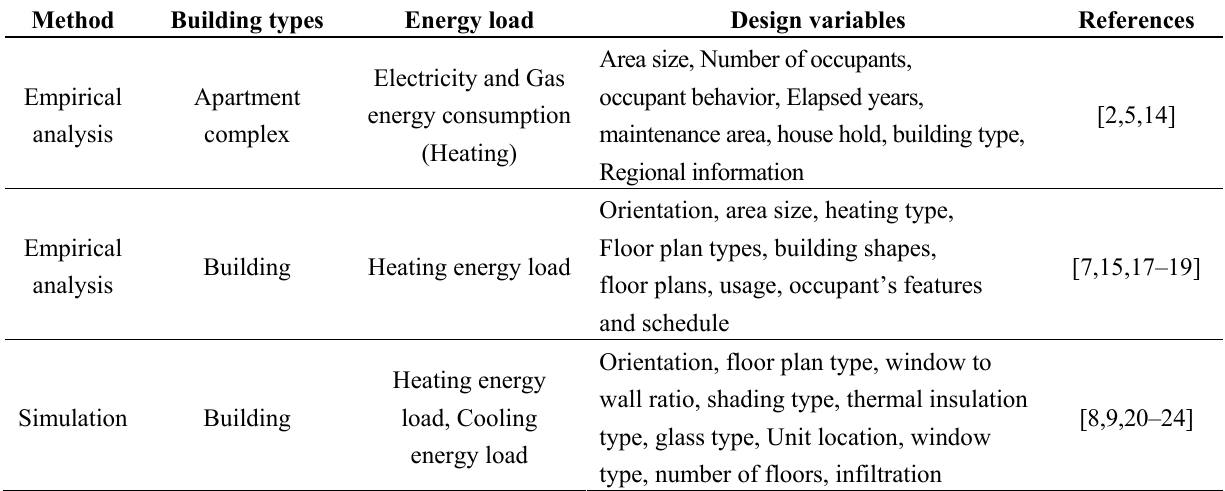
Table 1. Literature review for building energy